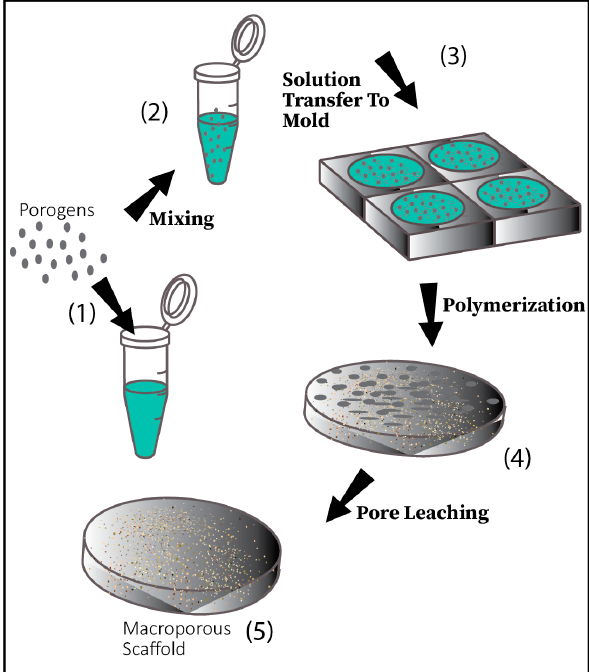
Figure 3. Porogen leaching technique.